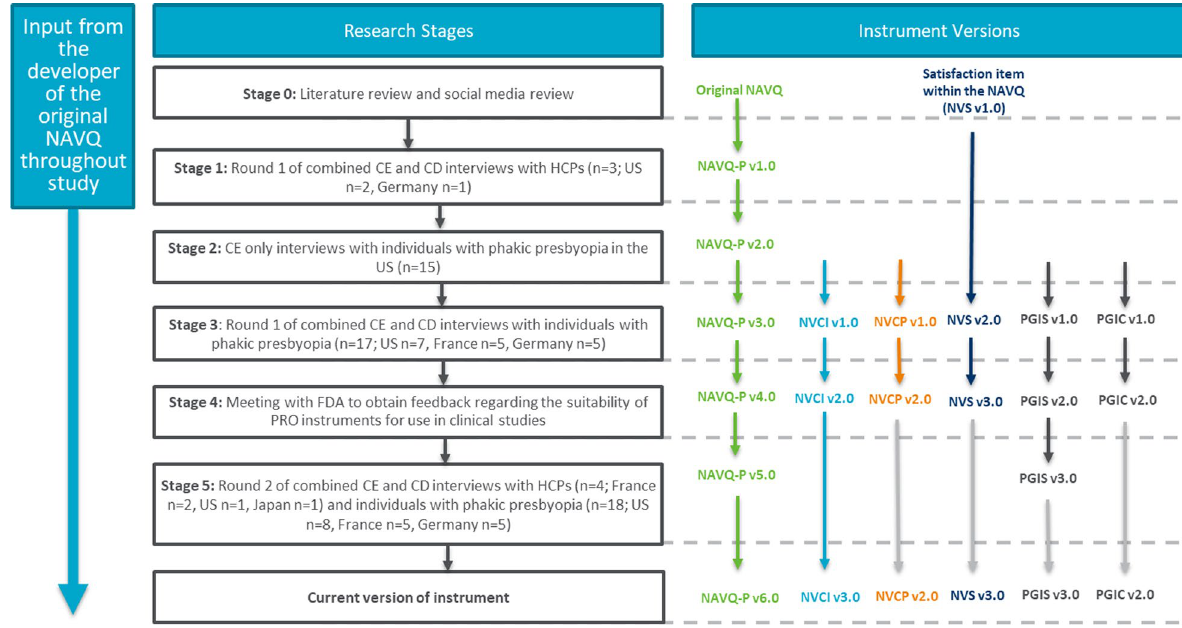
Fig. 1 Study methodology. * CE concept elicitation, CD cognitive debriefing, HCP healthcare professional, FDA US Food and Drug Administration, PRO patient‑reported outcome, NAVQ-P Near Activity Visual Questionnaire for Presbyopia, NVCI Near Vision Correction Independence, NVCP Near Vision Correction Preference, NVS Near Vision Satisfaction, PGIS Patient Global Impression of Severity, PGIC Patient Global Impression of